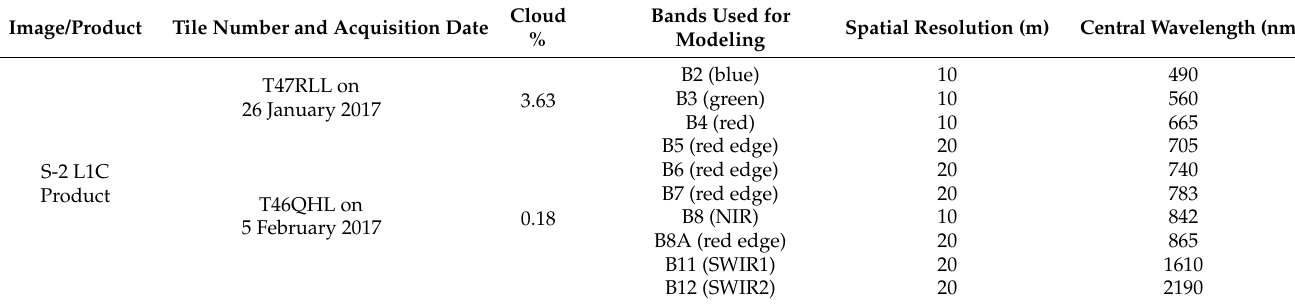
Table 1. Descriptive information of the images used in the